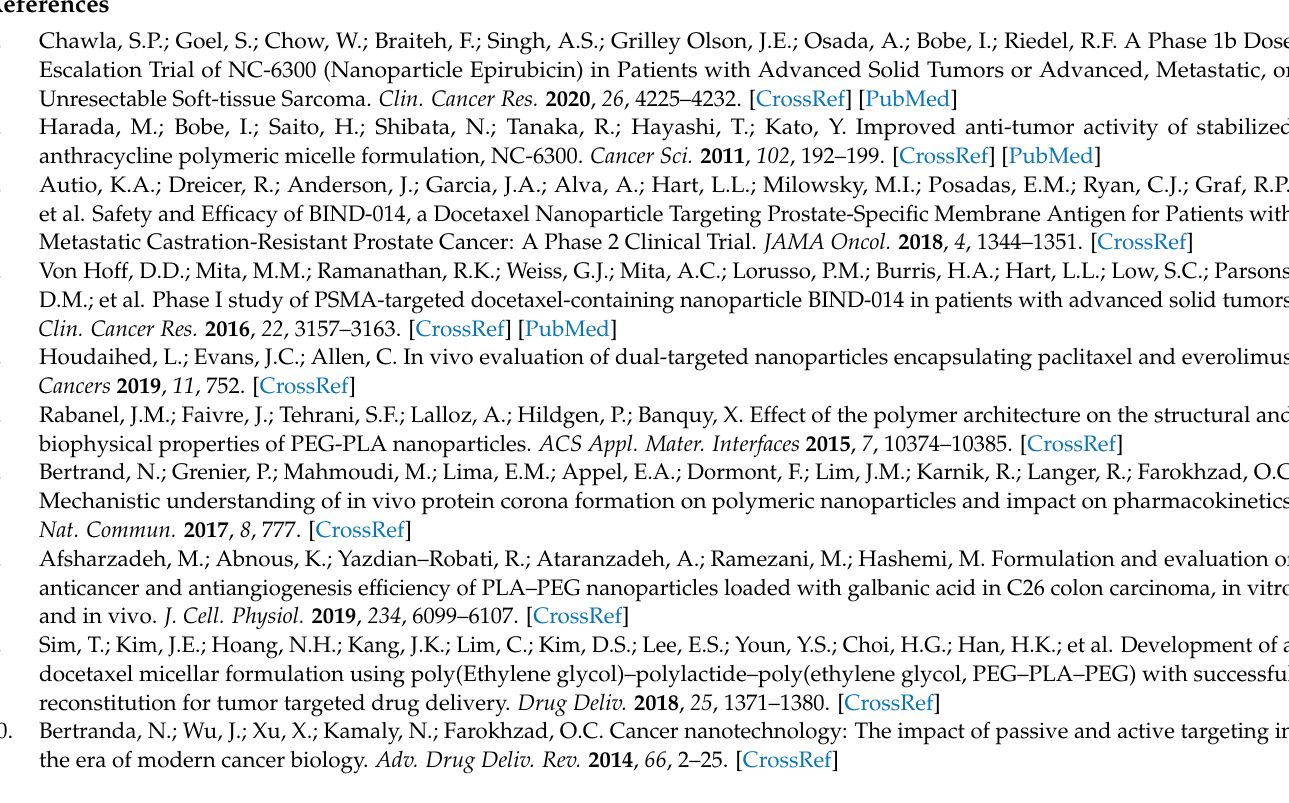
(NPs), Figure S3: Hydrodynamic diameters (Dh), polydispersity index (PdINP), surface PEG densities, and surface PEG contents of SC-PEG nanoparticles (NPs) prepared by different process conditions, Figure S4: Melting temperature (Tm) of PLA domain in lyophilized SC-PEG nanoparticles (NPs) pre- pared by different processing parameters and Table S1: Relative molecular weight and polydispersity of SC-PEG unimer in DMF containing